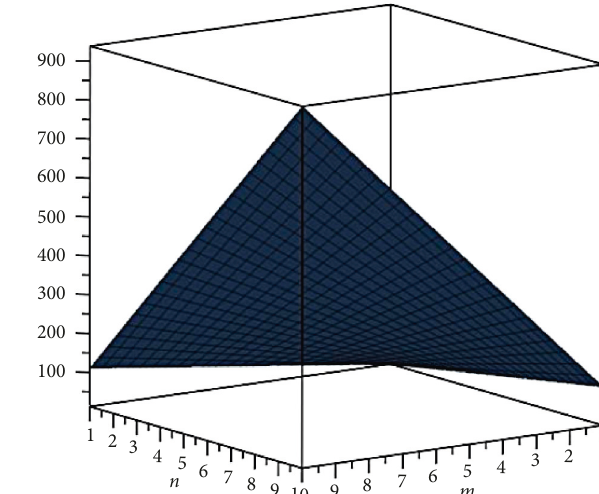
Figure 8: Graphical depiction of Table